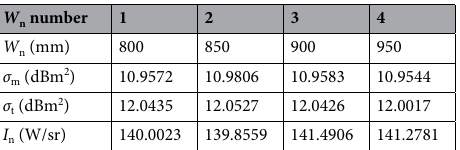
Table 3. Comparison of stealth indicators of aircraft under different W n .